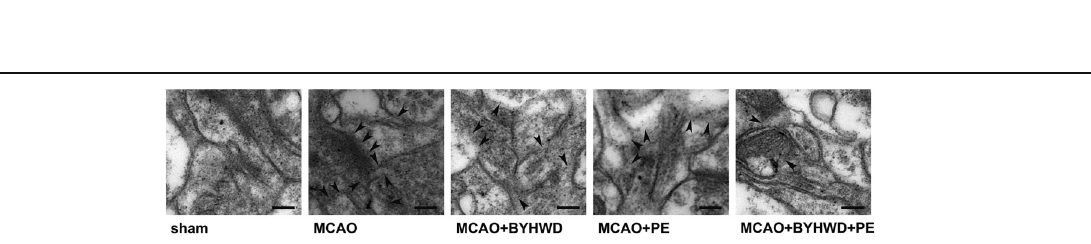
Fig. 6 TEM micrograms. Representative synapse ultrastructures of all groups. An intact synaptic ultrastructure is shown in panel sham , and a disorderly synaptic ultrastructure is illustrated in panels MCAO, MCAO + BYHWD , MCAO + PE and MCAO + BYHWD + PE . The arrowheads presented in panels MCAO , MCAO + BYHWD , MCAO + PE and MCAO + BYHWD + PE indicate the synaptic disruptions. Scale bars =200